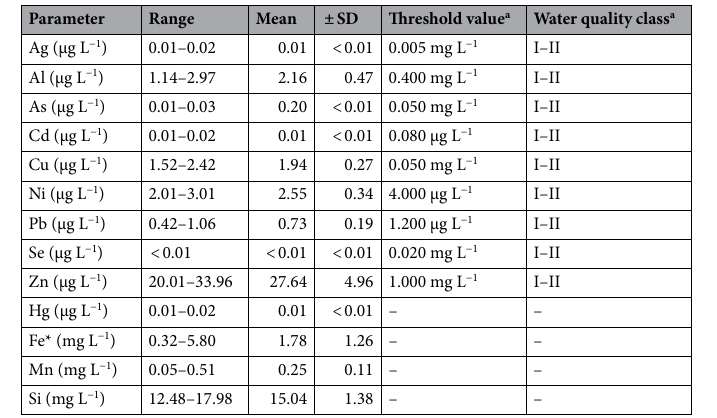
Table 1. Content of trace elements in the Kuźnica clarification pond in 2014–2019 compared to threshold values and classification of water quality (Regulation of the Minister of Maritime Economy and Inland Navigation, 2019 a ). – not defined. *Statistically significant differences at the significance level P = 0.0028 (see Supplementary Table S3 for detailed